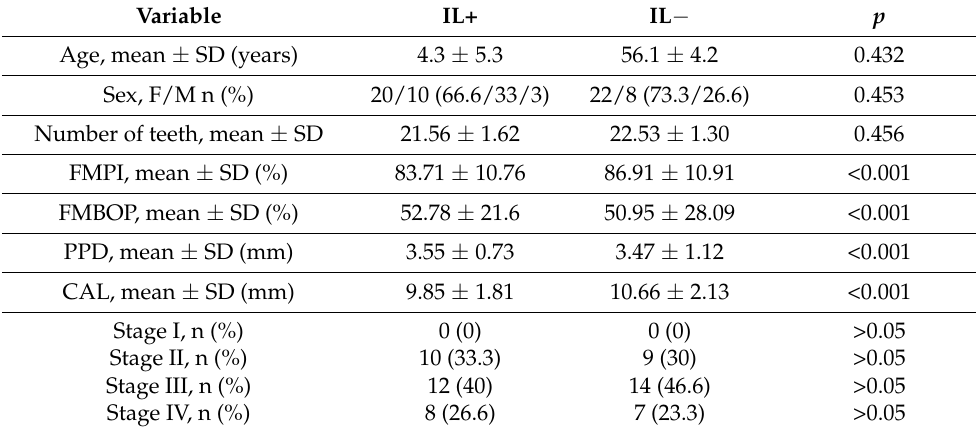
Table 1. Characteristics of the studied